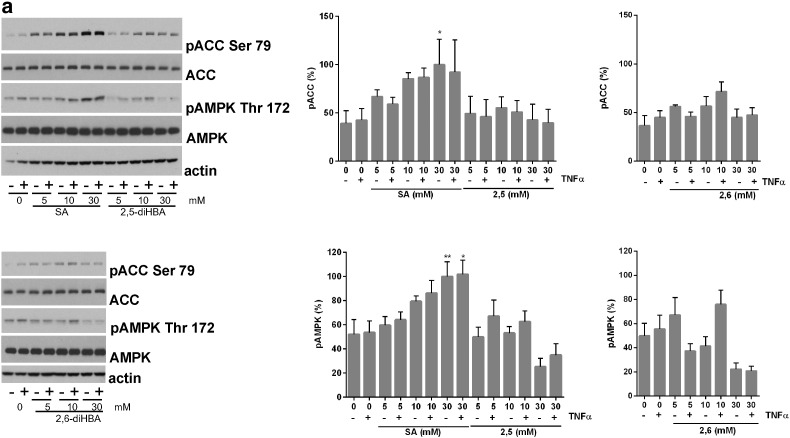
Dose–response of SA and its analogues on signalling in wild type and AMPK double knockout primary hepatocytes.(a, b) Primary mouse hepatocytes were treated in the presence or absence of 5–30 mM SA and the analogues shown for 3 h prior to treatment with 10 ng/ml TNFα (final 15 min). Signalling responses were measured using antibodies described in Fig. 1, Fig. 2. Densitometry of blots was carried out as described in Materials and methods. Treatments significantly different from the appropriate control column (+/− TNFα) are shown; ⁎⁎⁎p < .001, ⁎⁎p < 0.01, ⁎p < .05, n = 4–5. (c) Cells were treated with varying doses of SA as in (a), except that hepatocytes extracted from wild-type (WT, black bars) mice were compared side by side with those extracted from liver-specific AMPK double knockout (KO, grey bars) animals. Treatments significantly different from the appropriate control column (+/− TNFα, KO/wild-type) are shown, n = 3.